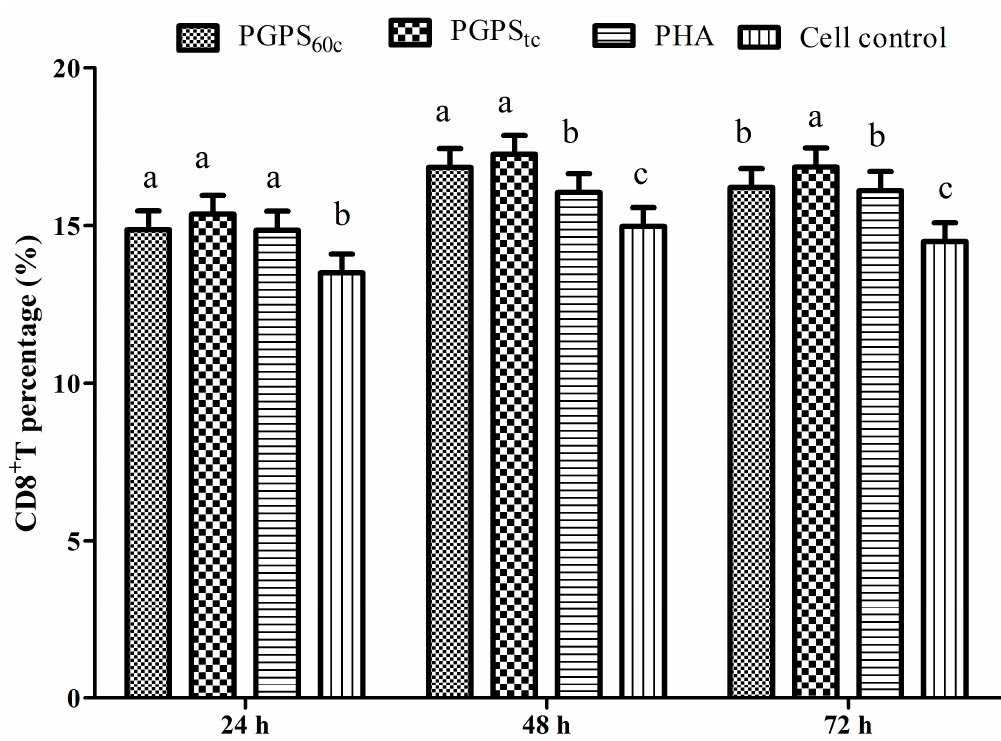
Figure 5. Changes of peripheral blood CD8 + T cells in stimulation of PGPSs or PHA. The values are presented as means ± SE ( n = 4). a–c Bars without the same superscripts differ significantly ( p < 0.05).